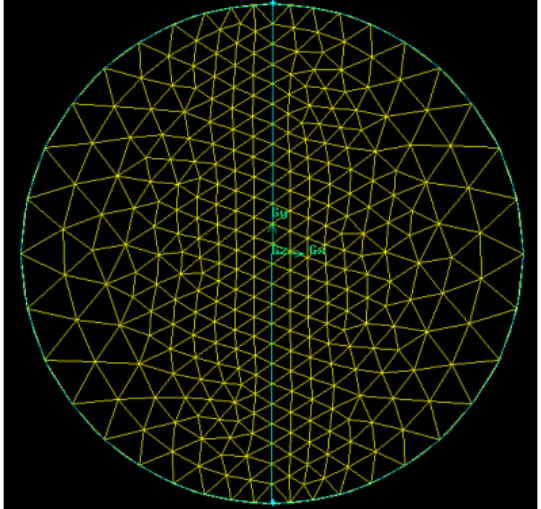
Figure 1. Model building and heterogeneous grid generation in Gambit.